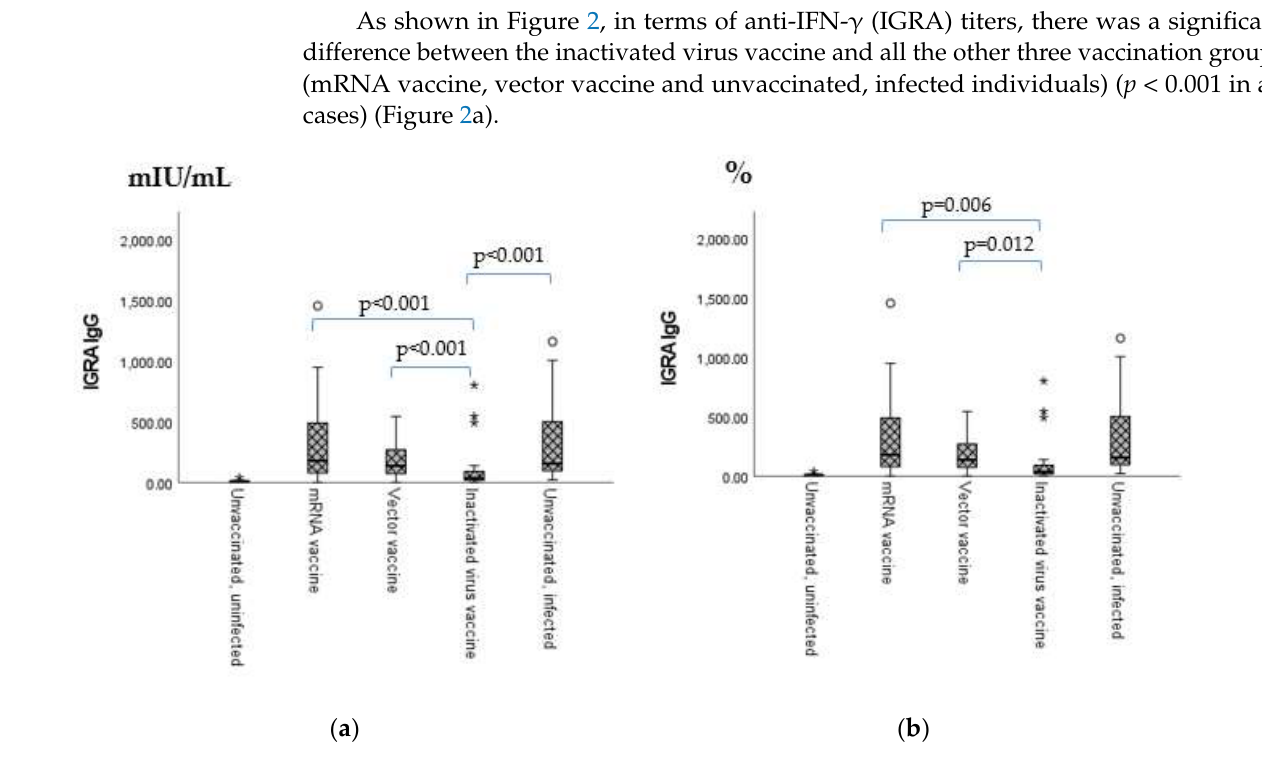
Figure 2. ( a ) Vaccination group-based comparison of antihuman IFN-γ release assay (IgG). ( b ) Vac- cination group-based comparison of neutralizing antibody titers (IgA/G/M). The sample numbers were as follows: mRNA-based vaccine (Pfizer–BioNtech) = 106, vector vaccine (AstraZeneca and Sputnik V) = 77, inactivated virus based vaccine (Sinopharm) = 34, unvaccinated, uninfected individuals (used as the negative control) = 9, and unvaccinated, infected individuals (used as